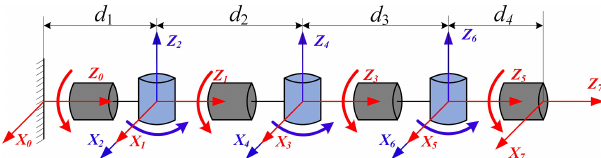
Figure 12. D–H model of a manipulator with 7 DOFs.